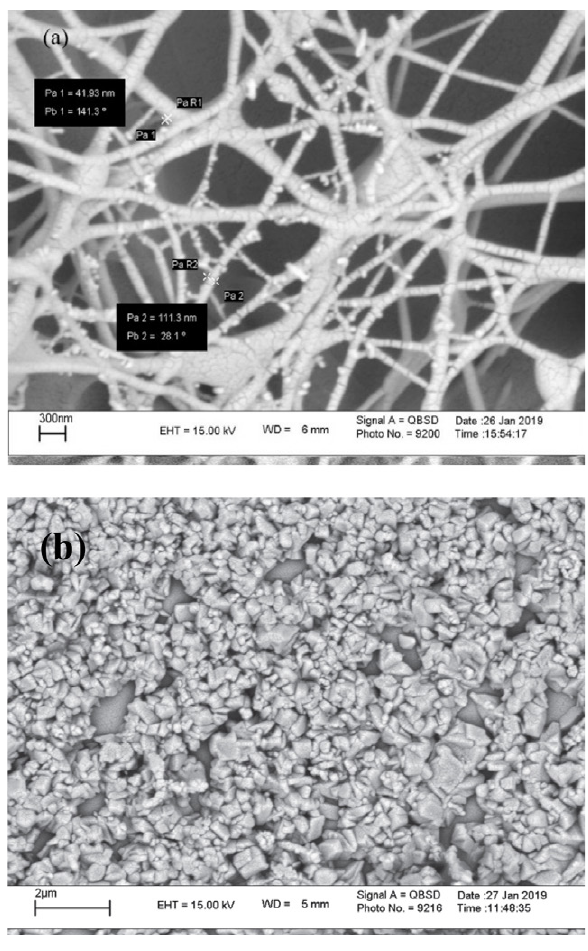
Figure 4 . SEM image of (a) CuO nanofibers (b) CuO nanofibers calcinated at 400 °C for 2 h.